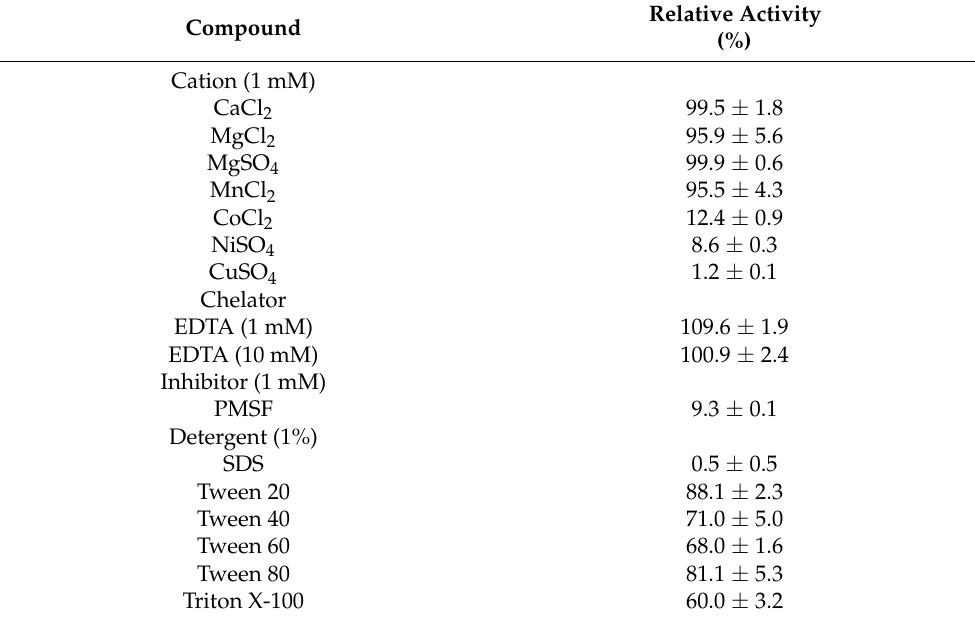
Table 3. Effects of various compounds on the stability of